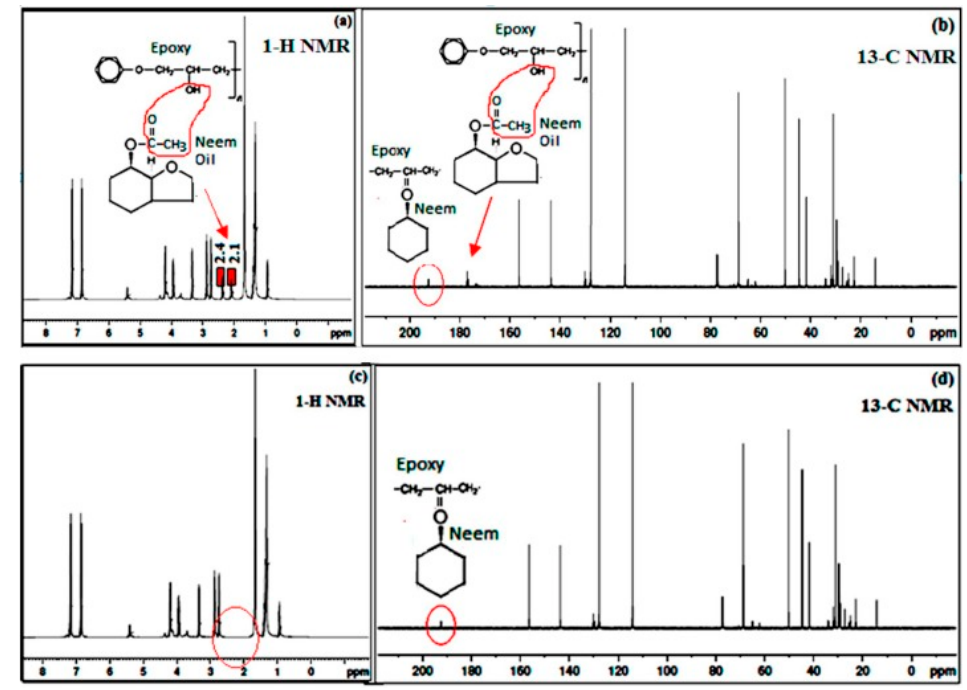
Figure 12. NMR: ( a ) 1 H NMR and ( b ) 13 C NMR analysis of epoxy–neem oil matrix at 80 °C, and ( c ) 1 H NMR and ( d ) 13 C NMR at 120 °C [177] (Reprinted/adapted with permission from Elsevier Ref. 5457240222636 Copyright 2018).